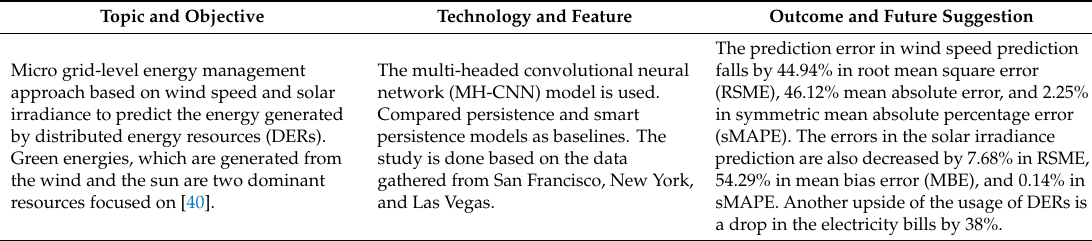
Table 4. Summary of the analysis of selected papers focusing on the energy management